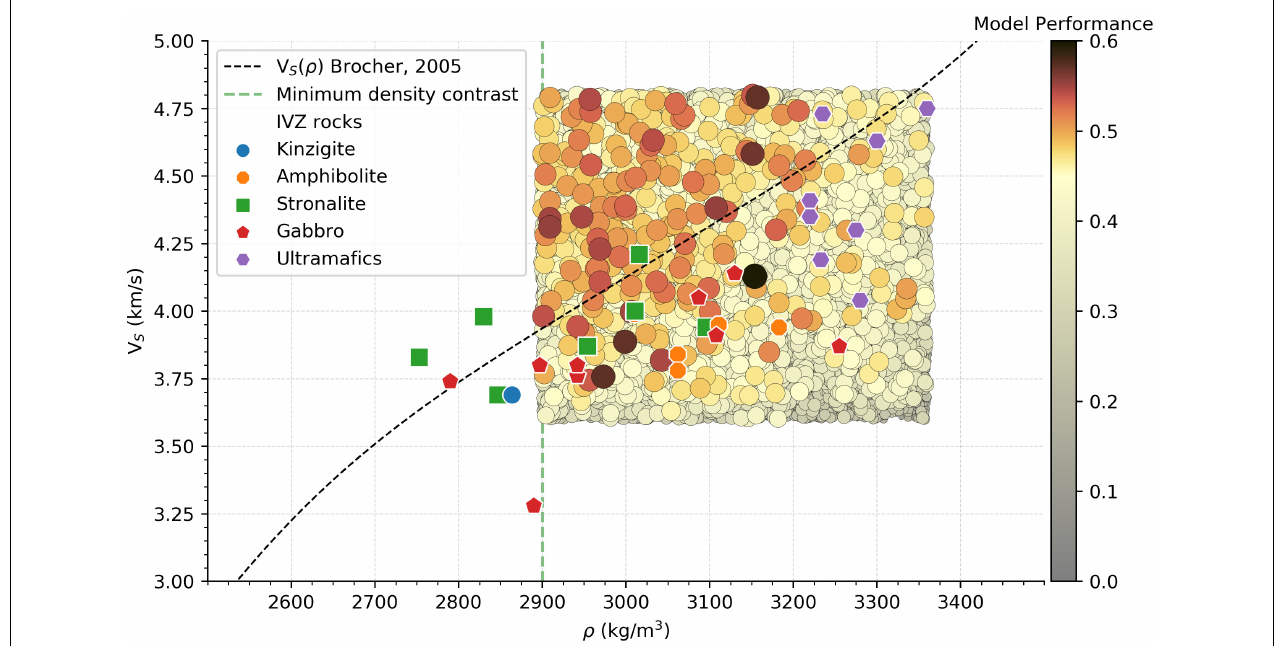
FIGURE 9 | Inversion results on the density and shear-wave velocity contrasts associated with the 2D model interface, shown as gray-contoured circles of size and color according to to the model performance. The background density and the background shear-wave velocity absolute values are common for all models (2700 kg/m 3 and 3.5 km/s, respectively). For comparison, the regression fit for the vs( ρ ) relationship from rocks discussed in Brocher (2005) (black dashed line) is shown together with a relevant set of rock physical properties across the IVZ from the SAPHYR catalog (Zappone et al.,